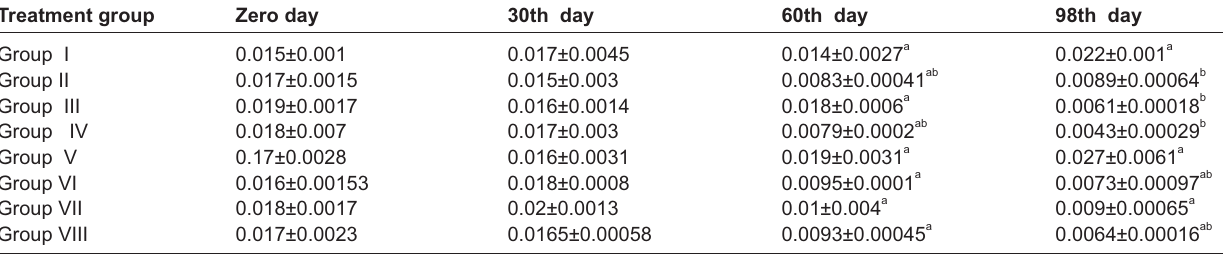
Values given are mean±SE of the results obtained from 6 animals. Means with at least one common superscript do not differ significantly at 5% ( P<0.05 ) Table-6. Effect of oral administration of chlorpyriphos, lead acetate, vitamin C alone, and in combinations on blood g lutathione–S-transferase activity (ìmole of conjugate of GSH-CDNB /min/ mg plasma protein) in rats. Treatment